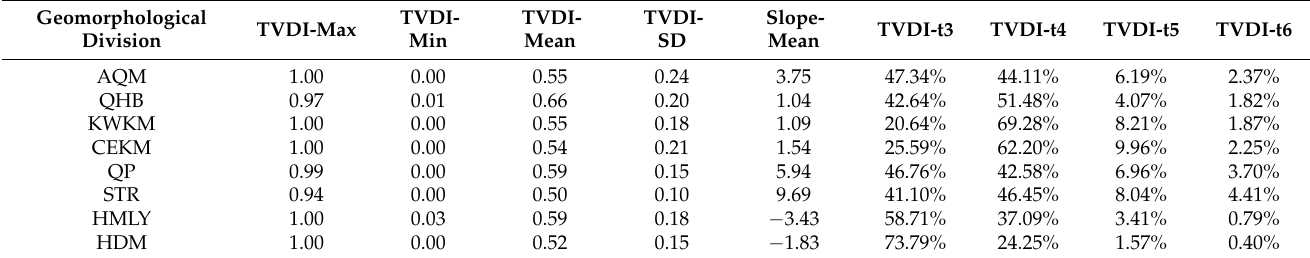
Table 5. Indicators of cluster analysis in each geomorphological division.